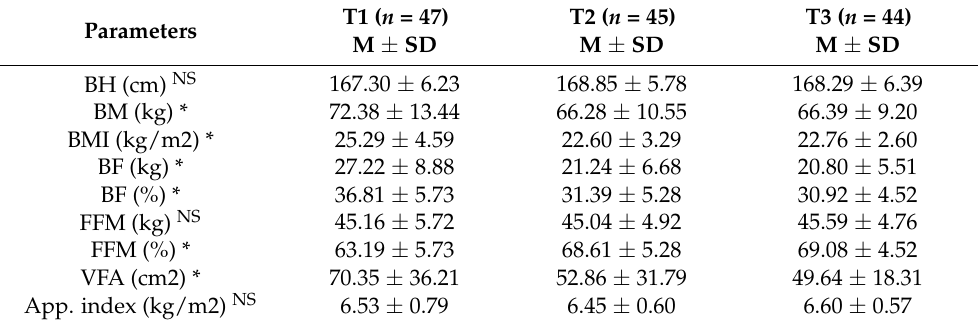
Table 3. Mean values of whole-body analysis of body composition in monitored women in the individual tertiles and differences determined by ANOVA (* statistically significant difference, NS no significant